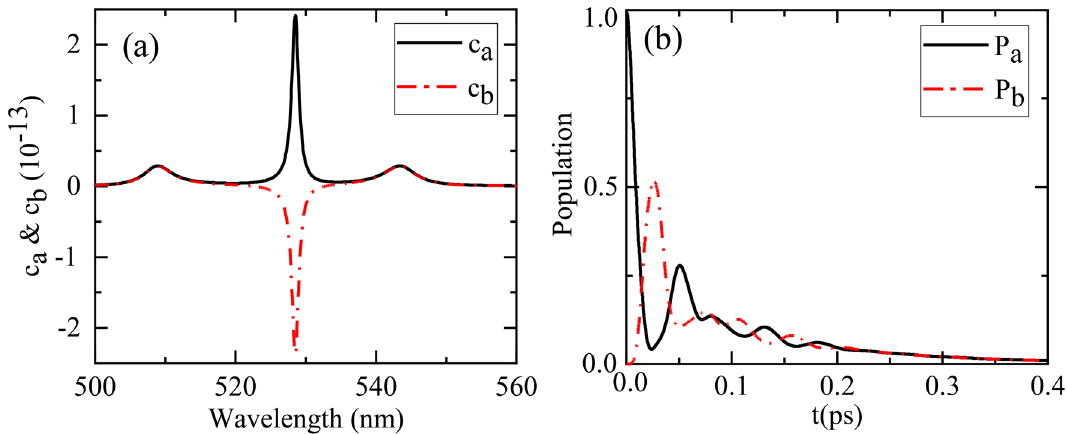
(cid:31) B (cid:31) r 525.6 nm . ( a ) = = =